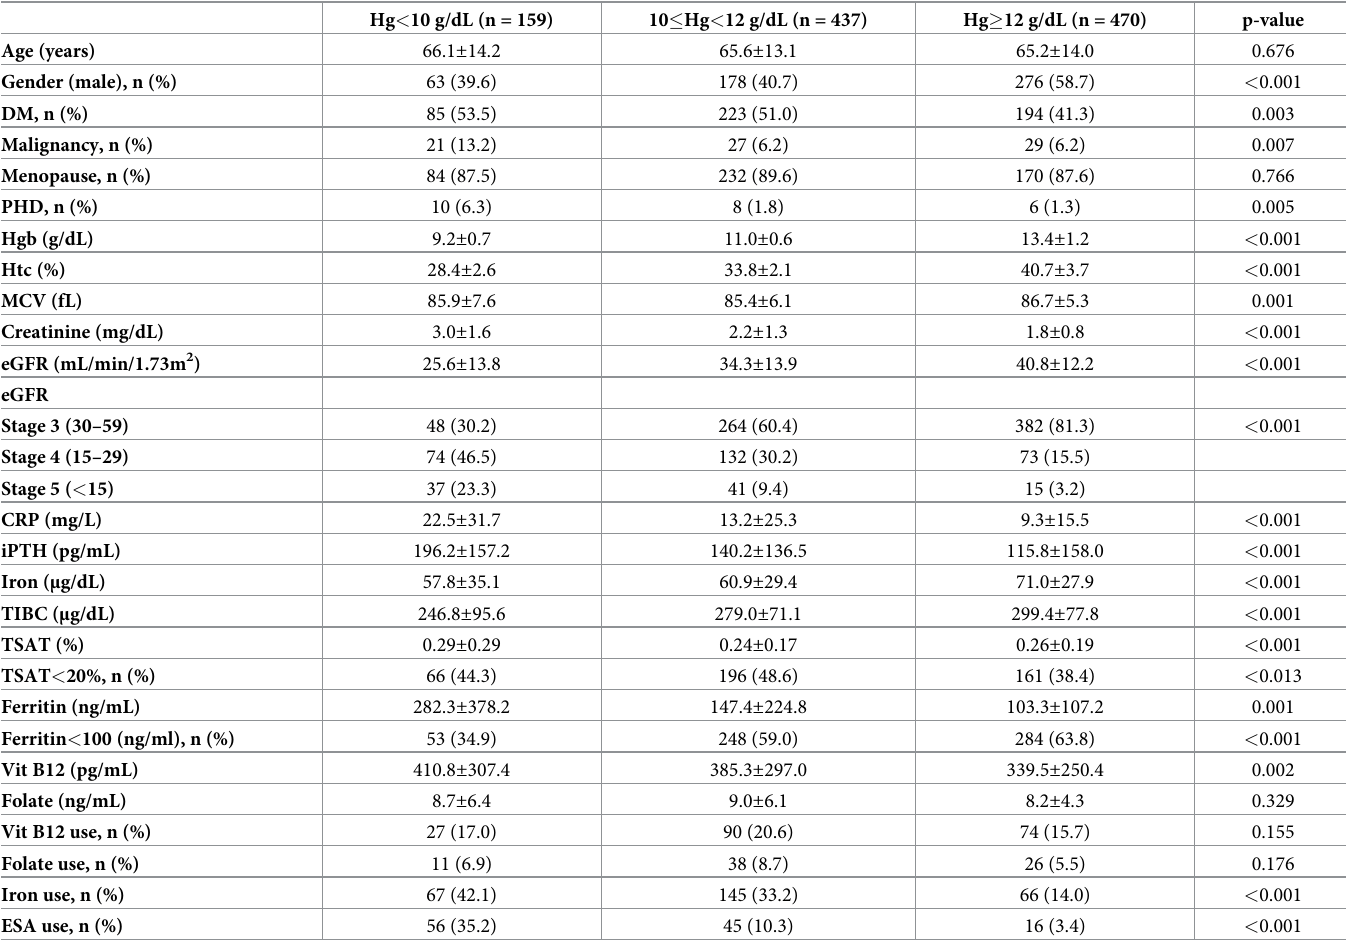
Table 2. Baseline characteristics of the patients according to hemoglobin